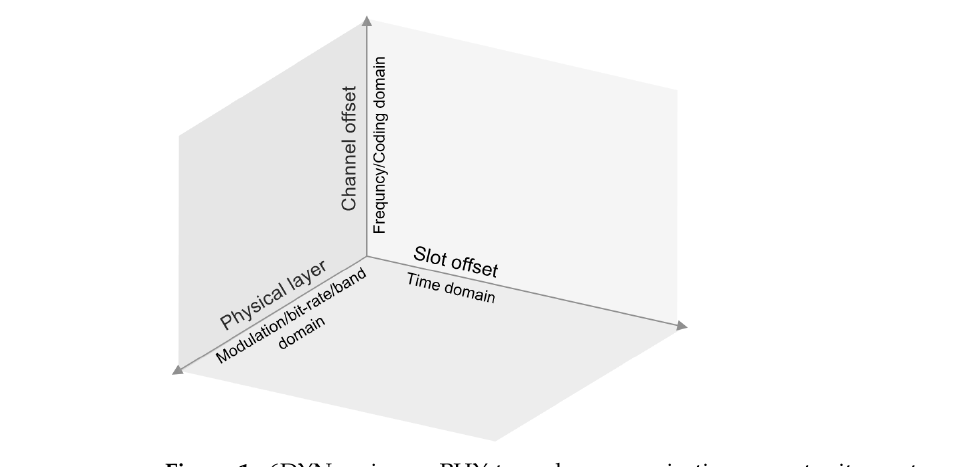
Figure 1. 6DYN assigns a PHY to each communication opportunity, on top of a timeslot and a channel offset.